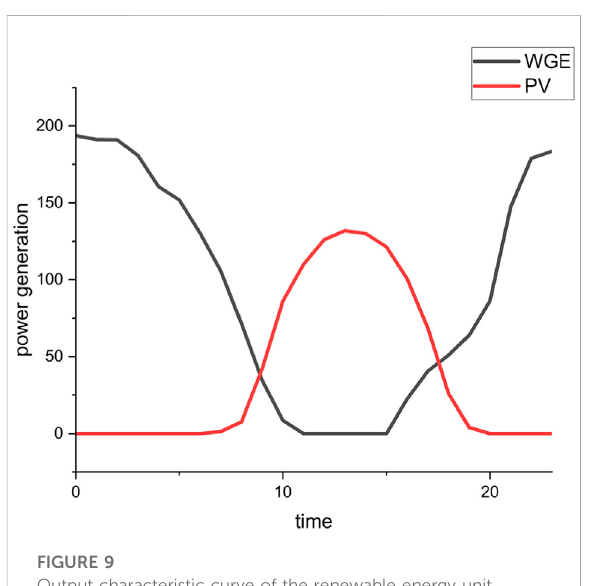
FIGURE 9 Output characteristic curve of the renewable energy